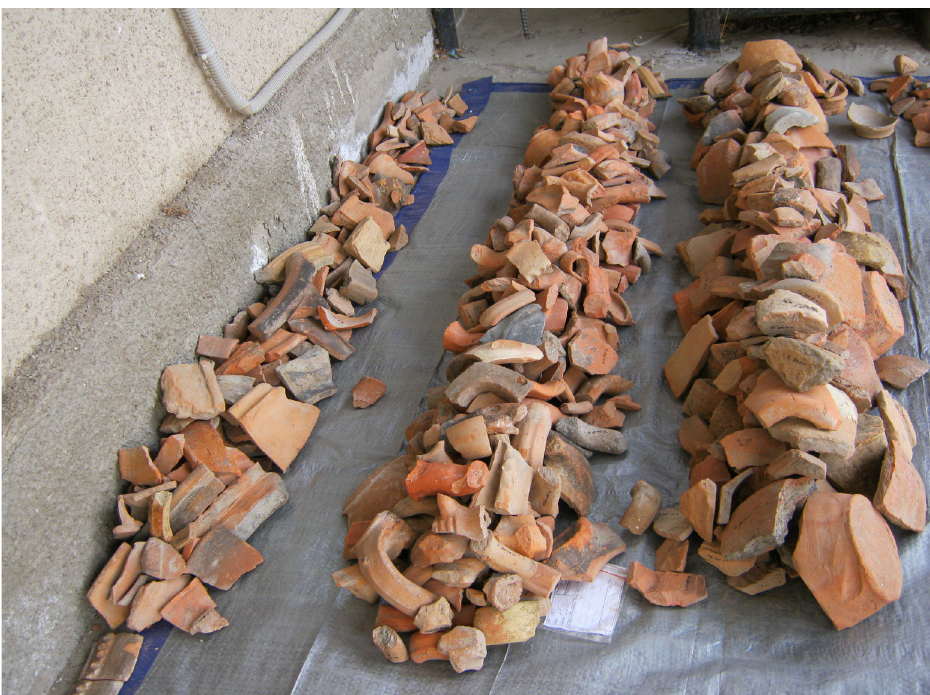
Fig. 10: Part of the exceptionally large ceramic assemblage from the Taraz excavation.